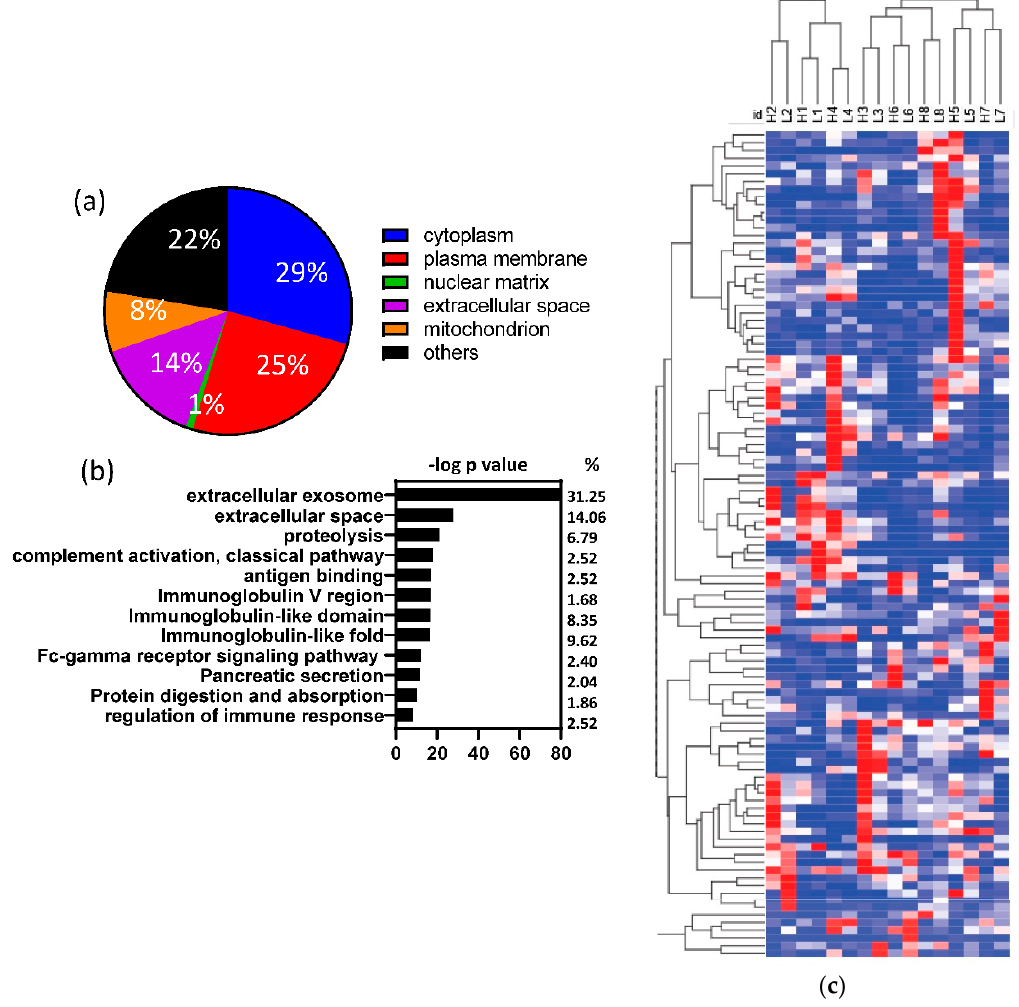
Figure 2. Fecal human proteins were not significantly different between the diets. ( a ) Cellular location of the fecal human proteins; ( b ) Enrichment analysis of the fecal human proteins; ( c ) Hierarchical cluster analysis of fecal human proteins. The same participant on different diets clustered together based on their fecal human proteins. The number denotes the participant number; H = high glycemic load, RG diet; L = low glycemic load, WG diet; ns: non-significant.